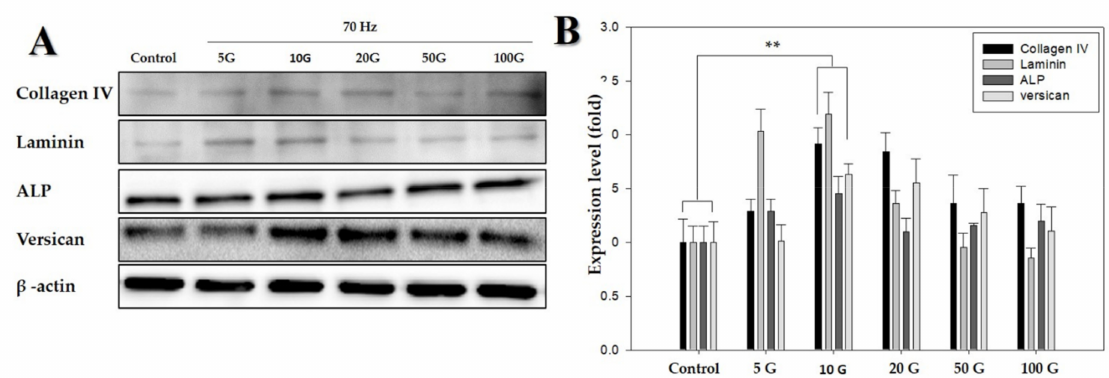
Figure 3. Western blot analysis of proteins detected in human dermal papilla cells (hDPCs) treated with an extremely low-frequency electromagnetic field (ELF-EMF). ( A ) Protein expression of collagen IV, laminin, ALP, and versican, using β -actin as an internal control; ( B ) protein expression level of collagen IV, laminin, ALP, and versican (with the control as the standard). β -actin was used in each lane as an internal control. Each bar represents mean ± standard error of independent experiments performed in triplicate ( n = 3). Significant di ff erences were determined by the Student’s t -test; ** p < 0.01.